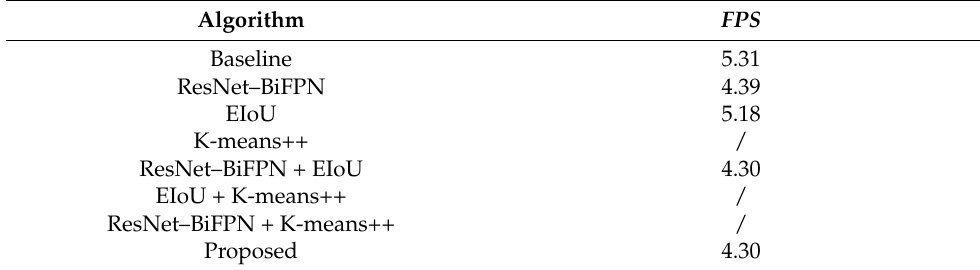
Table 3. Impact of improvements on network performance.